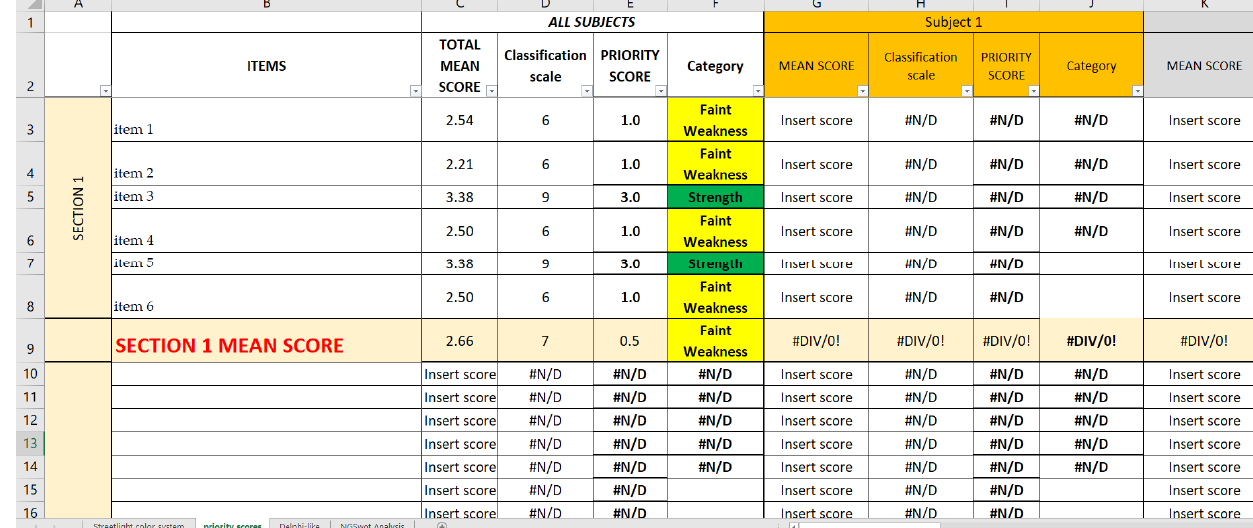
classification scale, the priority score, and the category, following the conversion table. The construc-